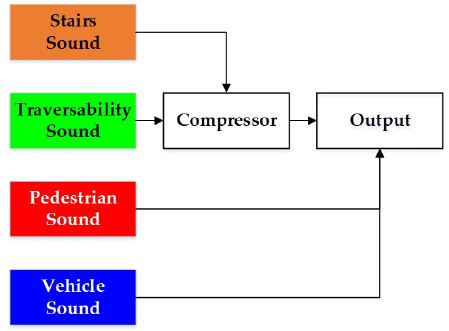
Figure 13. The mutual interaction between different sound mapping sources for navigation